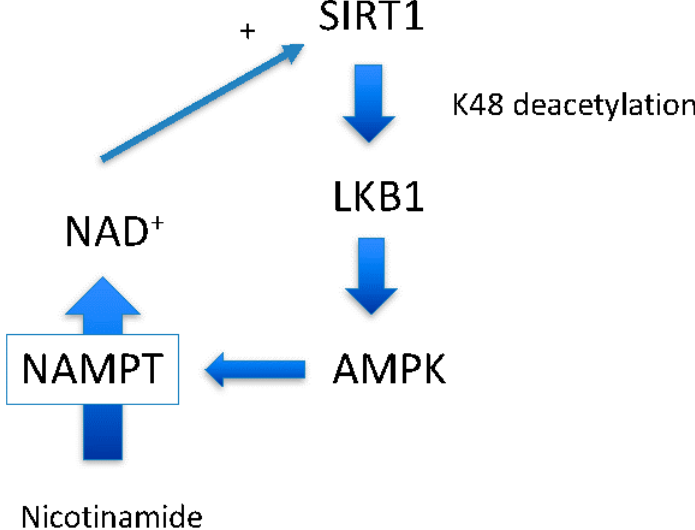
Figure 1. Proposed positive feedback loop to maintain a healthy metabolism. SIRT1-LKB1-AMPK forms a positive feedback loop though NAD + by NAMPT. This loop maintains cell health.